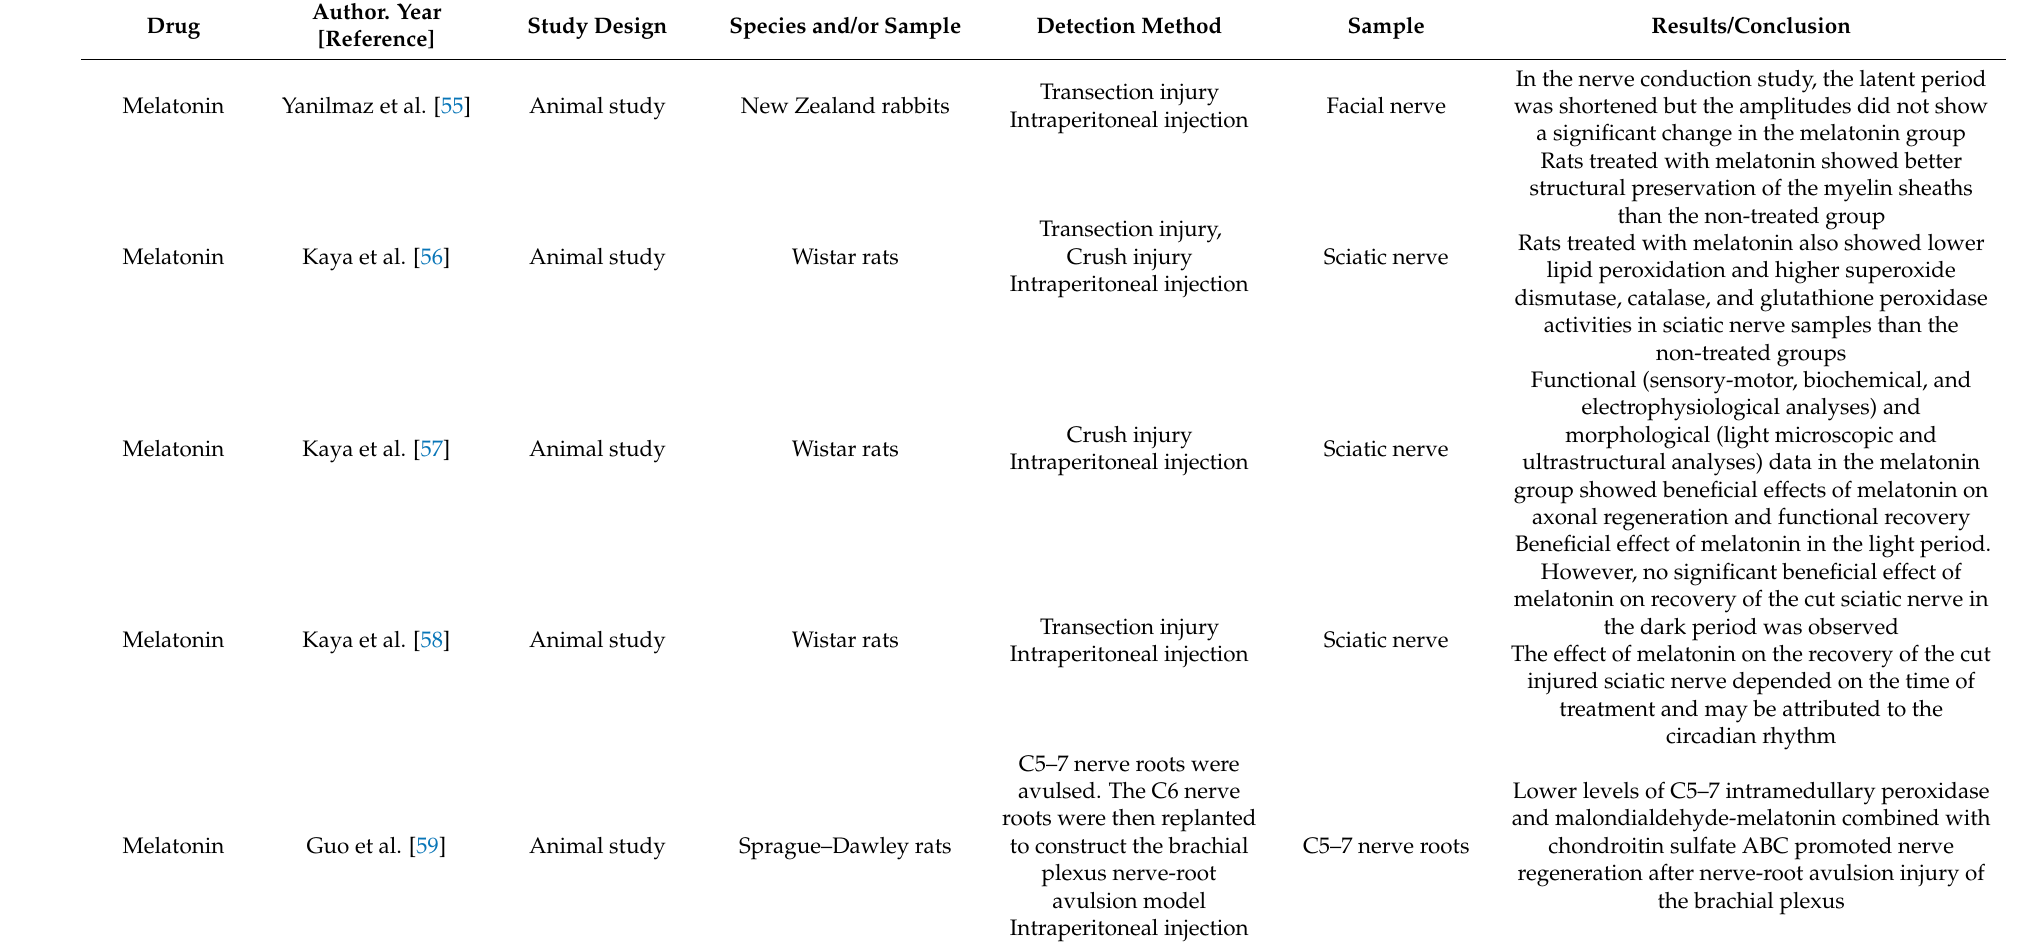
Table 4. Summary of studies assessing melatonin for the treatment of peripheral nerve